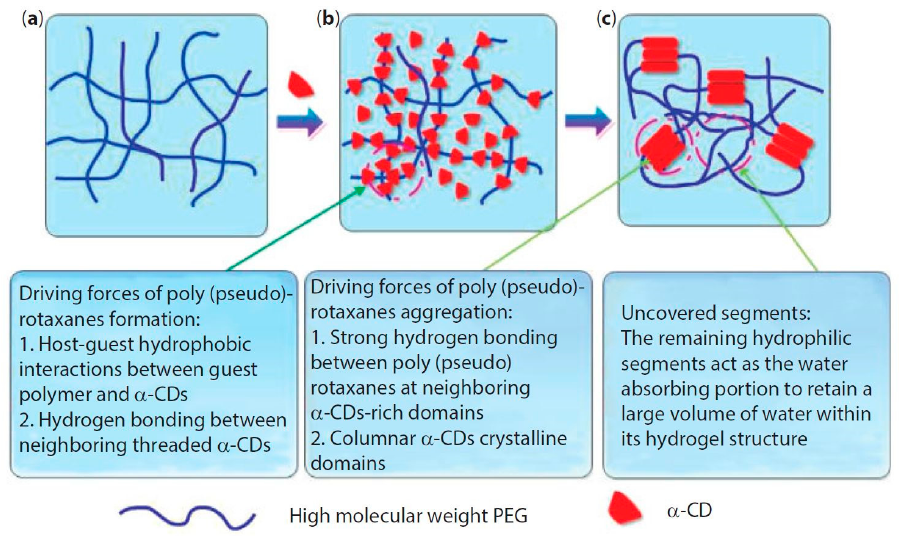
Figure 2. Formation of polypseudorotaxane hydrogels from α -cyclodextrin and high molecular weight poly(ethylene glycol) (PEG). ( a ) PEG aqueous solution without α -cyclodextrin ( α -CD); ( b ) α -CD is added and threads onto the polymer chain to form polypseudorotaxanes; and, ( c ) the aggregation of polypseudorotaxanes and exposition of remaining hydrophilic PEG segments give rise to hydrogels. Reprinted with permission from [48]. Copyright (2014) Scrivener Publishing LLC.